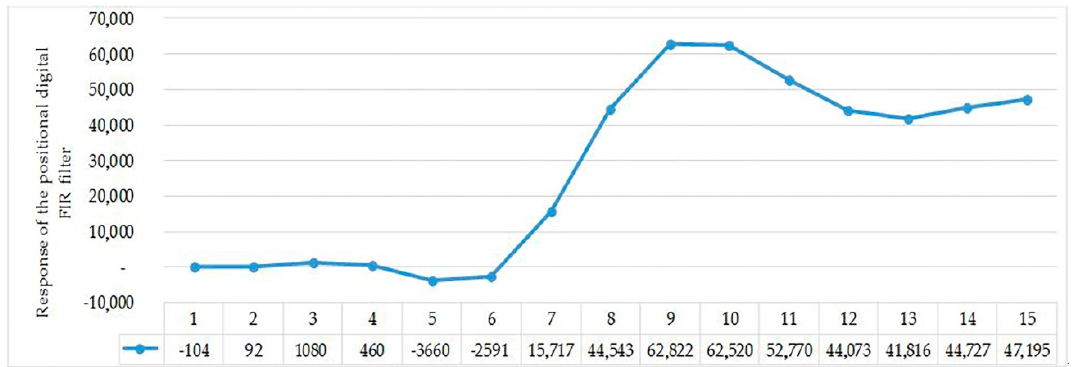
Figure 5. Response of the positional digital FIR filter.